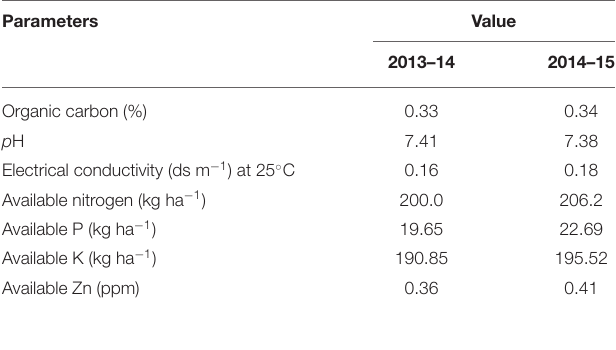
TABLE 4 | ANOVA ( p values) for rice grain yield, and nitrogen, phosphorus and potassium uptake. Source of variance p value Significance level